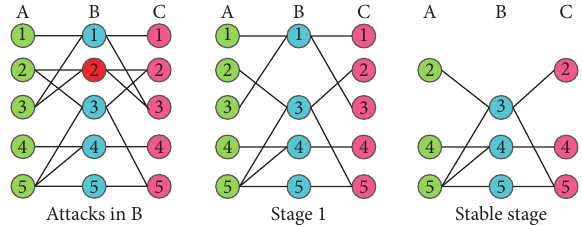
Figure 4: An example of the global model for describing the cascading failures on multipartite networked systems subject to node failures. Initially, node 2 from partite set B of a tripartite network is removed. In Stage 1, the removal of node 2 breaks the focal network into two clusters, and all the nodes that are not in the LCC are removed. In the final stage, only the nodes in the LCC are